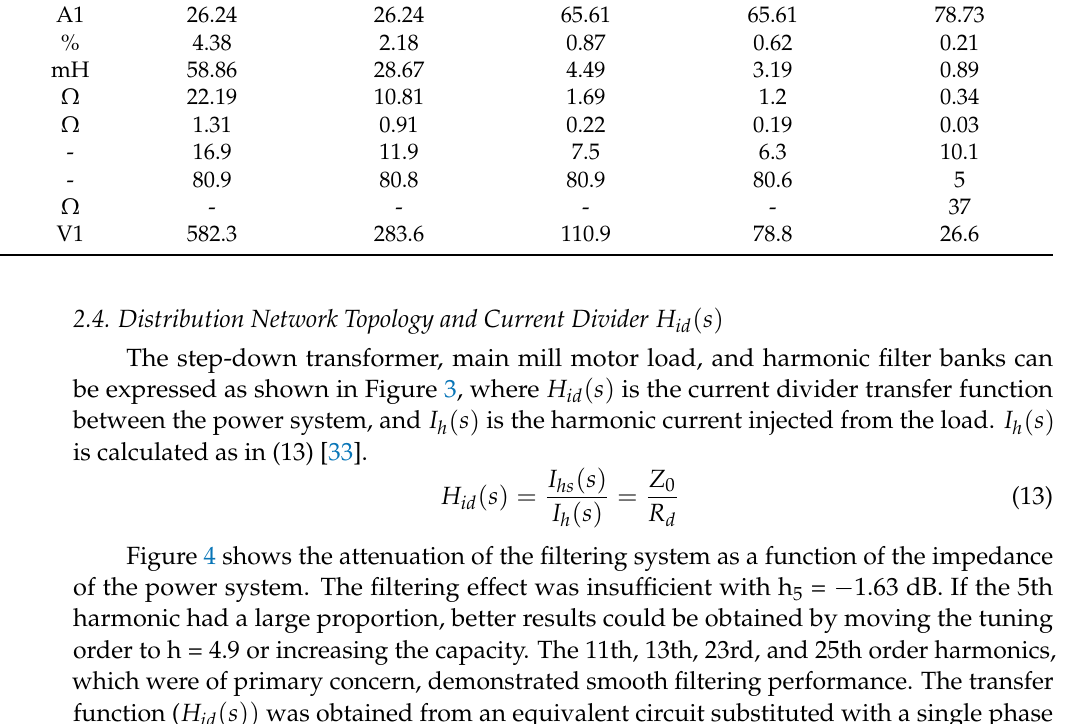
Table 4. Harmonic filter design parameters.